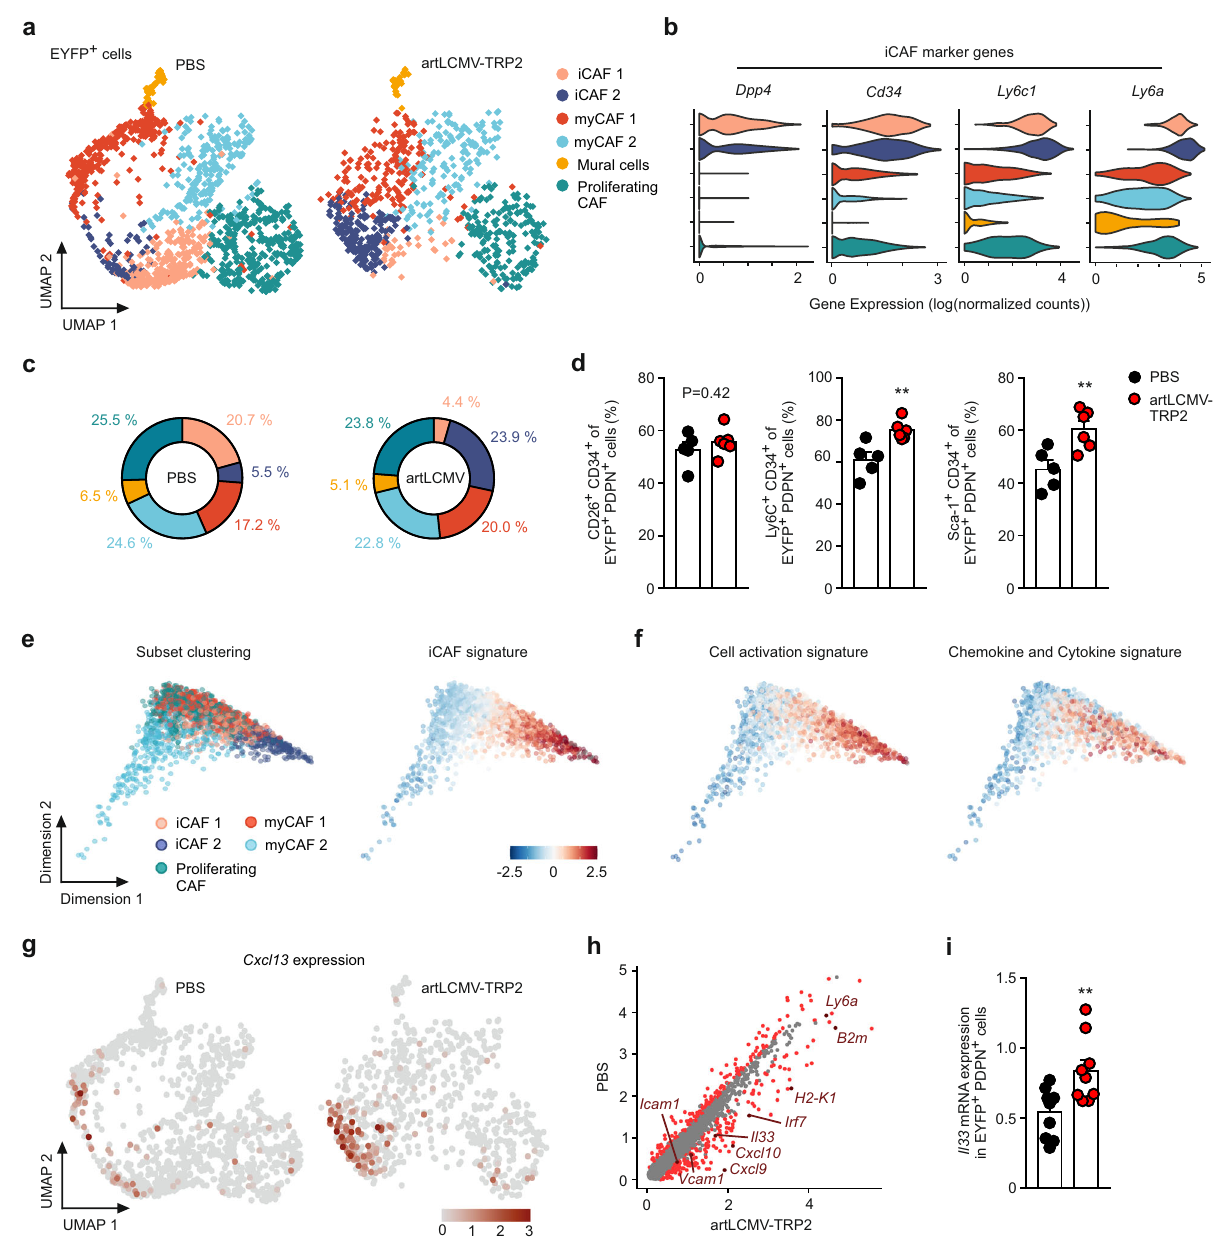
Fig. 5 Activation of Cxcl13 -expressing immune-stimulatory FSCs by intratumoral artLCMV-TRP2 treatment. Single-cell RNA-seq analysis of EYFP + cells isolated from the tumors of Cxcl13-Cre/ tdTom EYFP mice treated i.t. with artLCMV-TRP2 or PBS on day 11. a UMAP plots displaying FSCs cluster assignment in PBS control or artLCMV-treated mice. b Violin plots depicting expression of iCAF marker genes Ly6c1 , Ly6a , Cd34 , and Dpp4 . c Pie charts showing the relative abundance of the identi fi ed FSC clusters. d Flow cytometric analysis of EYFP + PDPN + cells stained for CD26 (Dpp4), CD34, Ly6C (Ly6c1), and Sca-1 (Ly6a/ Ly6e). e , f Diffusion maps of EYFP + tumor FSCs with trajectories constructed based on differential genes analysis in clusters iCAF1 and iCAF2 between PBS and artLCMV condition. e Diffusion maps showing subset clustering and iCAF signatures and f cell activation signature and chemokine and cytokine signature. g UMAP feature plots of Cxcl13 expression. h Scatter plot depicting DE genes of iCAF1 and iCAF2 between PBS control and artLCMV-TRP2-treated mice. i Real-time PCR analysis for Il33 expression in EYFP + PDPN hi sorted cells from tumors of Cxcl13-Cre/tdTom EYFP mice. ScRNA-seq analysis was performed with one biological replicate for n = 6 PBS-treated mice and two biological replicates for n = 3 – 4 artLCMV-TRP2- treated mice. We obtained 1293 (PBS) and 786 (artLCMV-TRP2) EYFP-expressing cells. Dots in d , i represent individual mice and shown is mean + s.e.m. values. Pooled data from two independent experiments with n = 5 (PBS) and n = 6 (artLCMV-TRP2) mice ( d ); n = 10 (PBS) and n = 9 (artLCMV-TRP2) mice ( i ). Statistical analysis was performed using unpaired two-tailed Student ’ s t test ( d , i ) with * P < 0.05: ** P < 0.01; *** P < 0.001. Source data and exact P values are provided in the Source data fi le. These data indicate that IL-33 is dispensable for the activation of did not reveal signi fi cant differences in the frequency of CD8 + CD8 + T cell effector function in the SDLN after local artLCMV- T cells (Supplementary Fig. 9b), or TRP2- and LCMV (GP33 and NP396)-speci fi c CD8 + T cell cytokine responses between Cxcl13- TRP2 immunization. Collectively, we conclude that IL-33 catered by Cxcl13-Cre + FSCs to CD8 + T cells in the TME sustains T cell Cre Il33 fl / fl and Cre-negative Ctrl mice (Supplementary Fig. 9b, f). NATURE COMMUNICATIONS| (2021) 12:4734